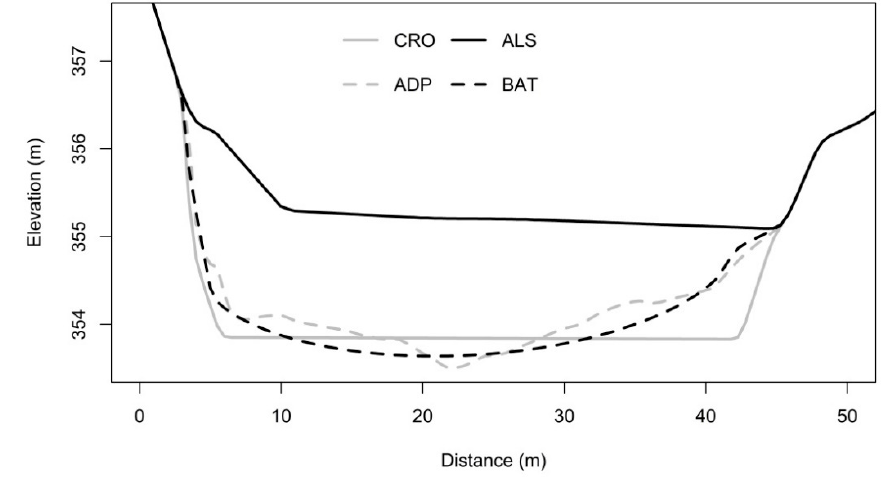
Figure 5. Visual comparison: Random cross-section derived from evaluated digital elevation models.